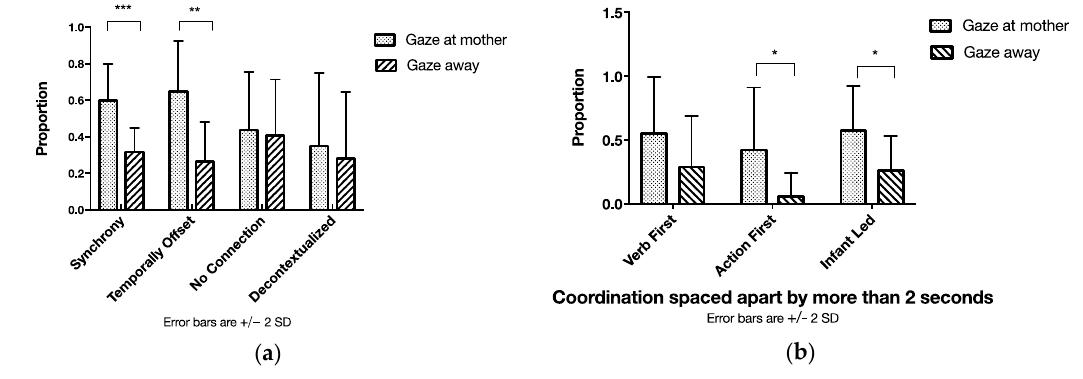
Figure 10. ( a ) Types of temporal coordination within a two-second time window overlapping with categories of infant gaze. ( b ) Types of temporal coordination offset by more than 2 s overlapping with categories of infant’s gaze (* p < 0.05; ** p < 0.01; *** p < 0.001).